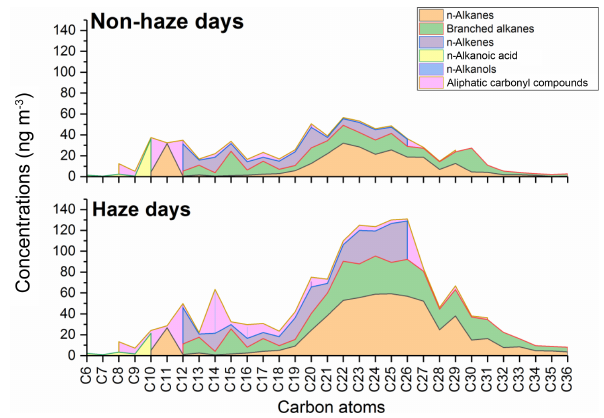
Figure 4. The molecular distributions of aliphatic hydrocarbons and other homologous series, including n-alkanes, branched alkanes, n-alkenes, carbonyl compounds (n-alkanals, n-alkan-2-ones and n- alkan-3-ones), n-alkanoic acid and alkanols on haze and non-haze